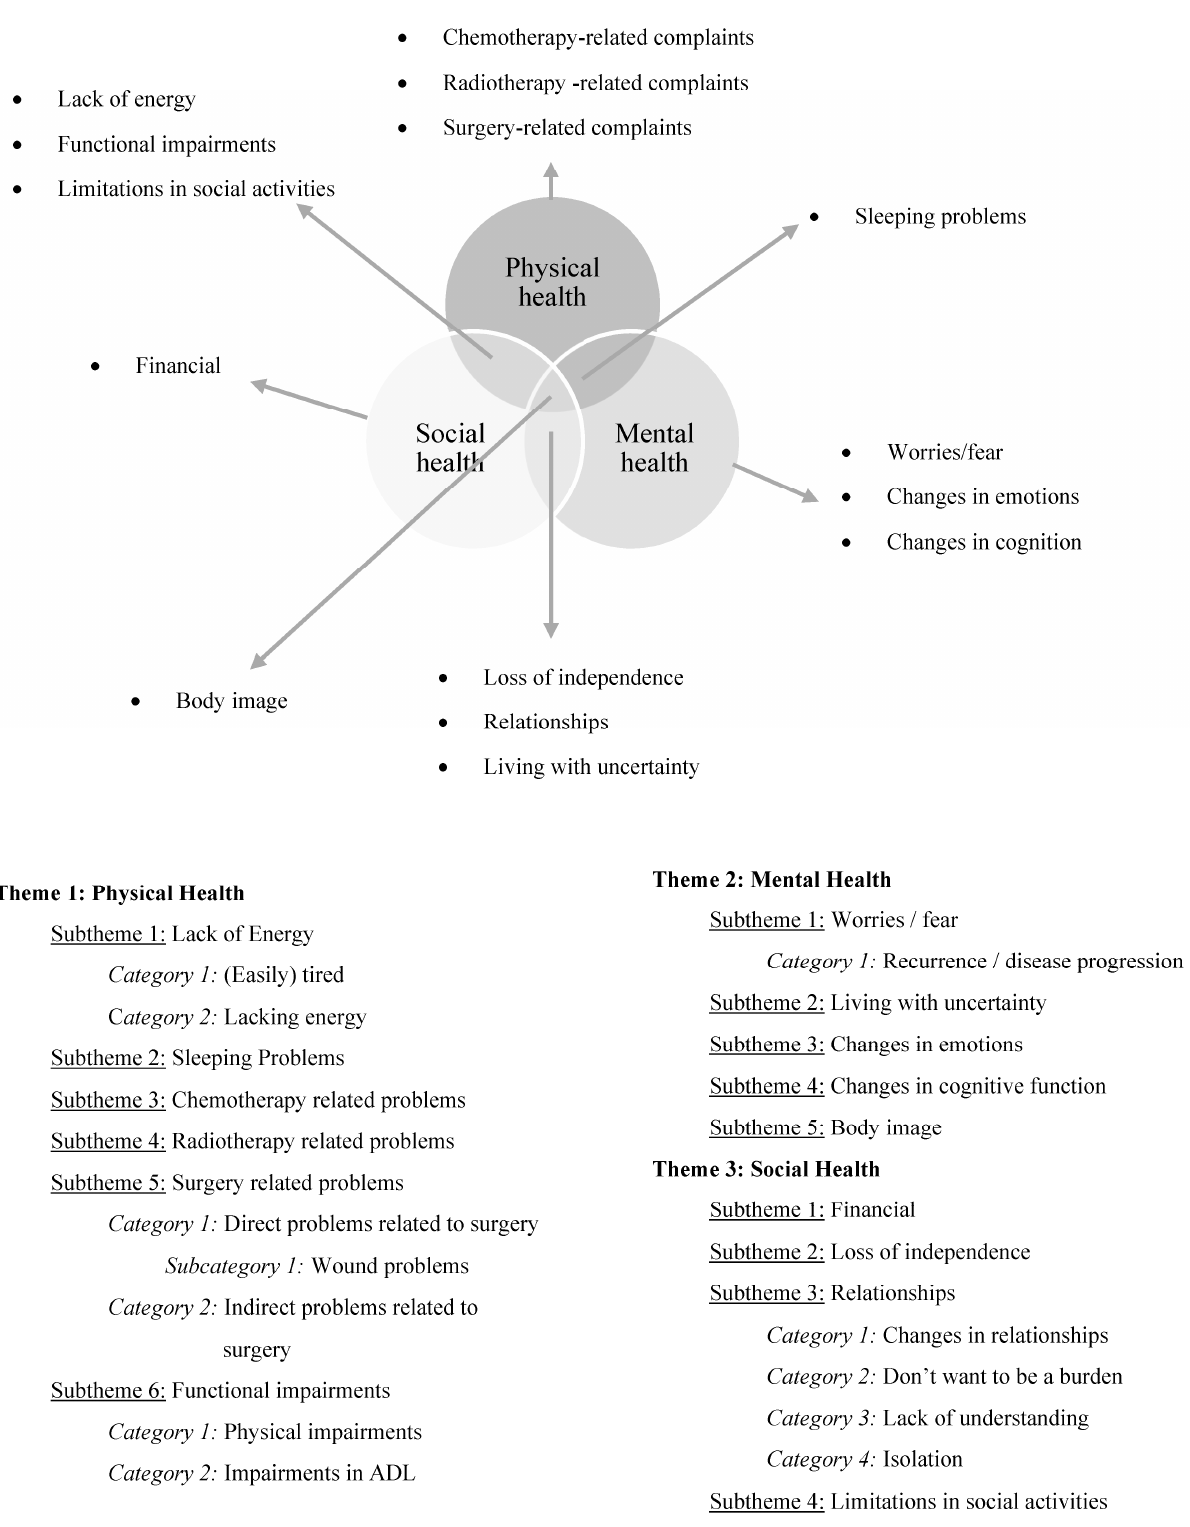
Figure 2. Three-dimensional theoretical framework of health for breast sarcoma patients and the different subthemes within the main themes physical, mental, and social health based on the biopsychosocial model.